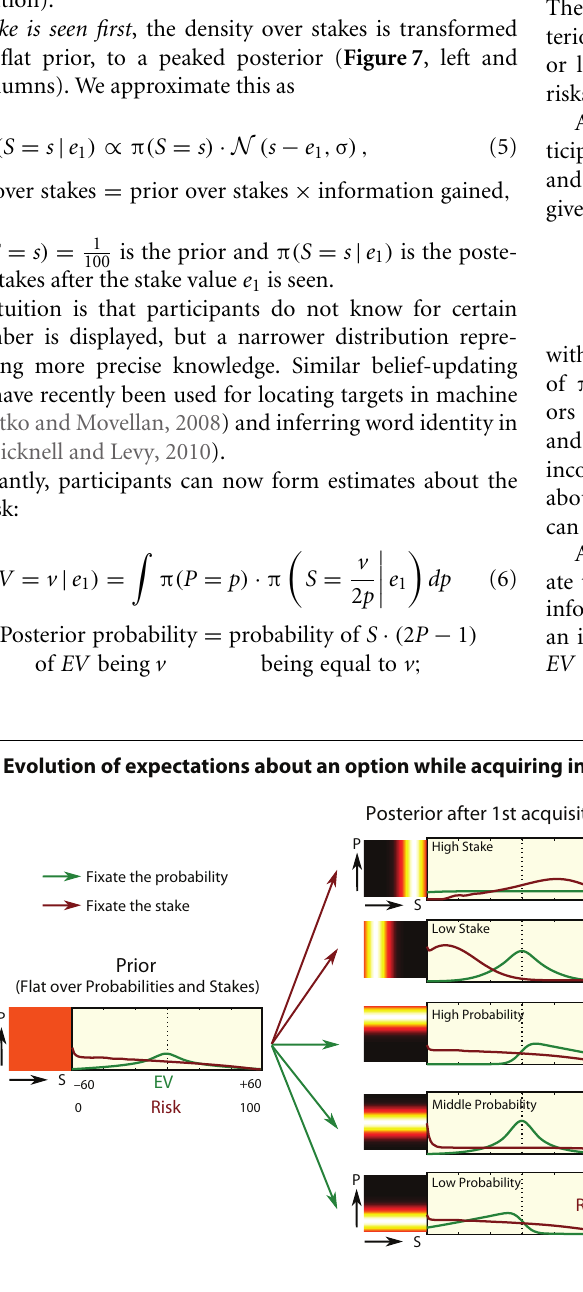
acquisition, either a probability or stake is seen, narrowing the distribution in that dimension, and altering the density of EV and risk. Second column: after the first acquisition, the participant shifts attention to the other value in the same option, and his estimate of EV and risk improves again. As more information is accrued by fixations, the distributions become more